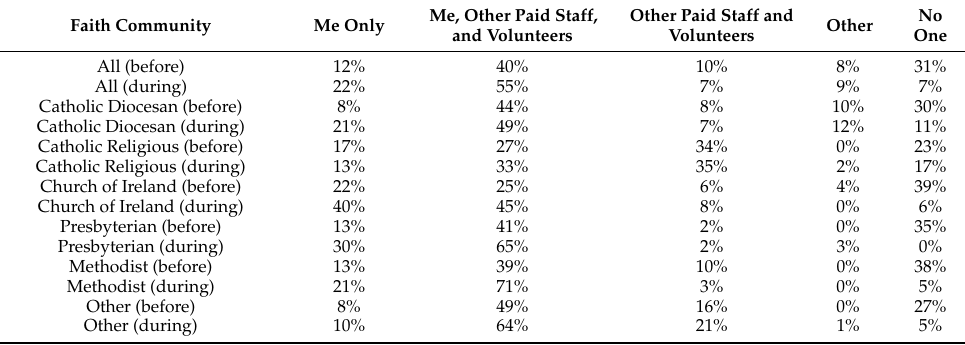
Table 2. Responsible for online worship/outreach before and during the pandemic. 17 Faith Community Me Only Me, Other Paid Staff, and